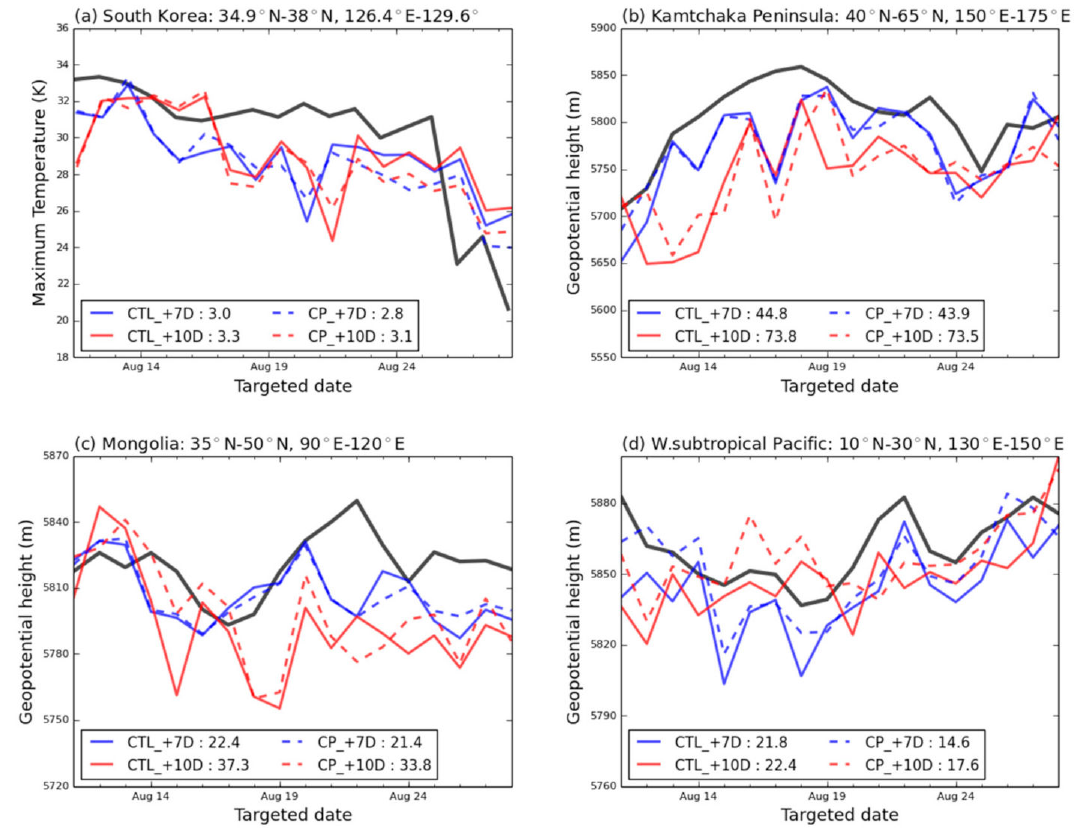
Figure 9. ( a ) Time series of daily maximum temperature ( ◦ C) averaged over South Korea in the CTL (solid line) and the CP (dashed line) experiments at each forecast day (blue for day 7, red for day 10) with the MetUM analysis (black). ( b – d ) are time series of 500 gph height averaged over ( b ) the